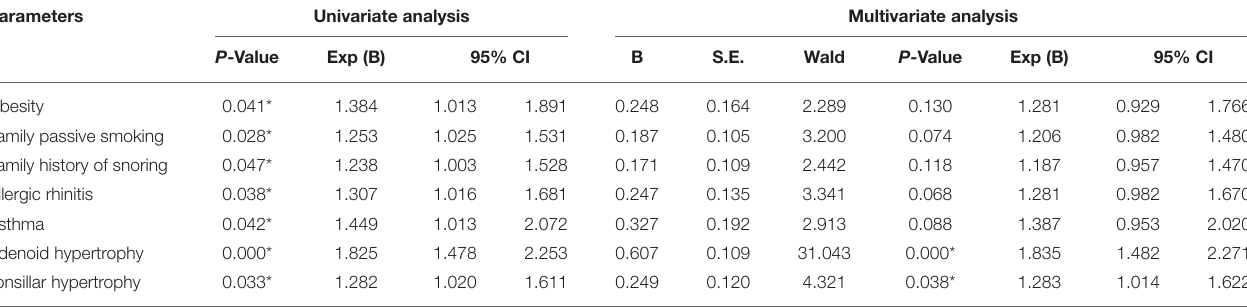
TABLE 2 | Univariable and multivariate logistic regression analysis of pediatric OSAS-related risk